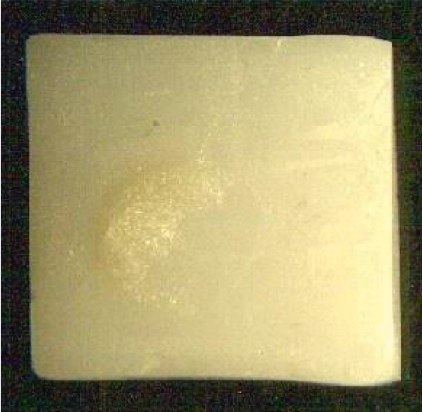
Figure 7: Mixed failure mode observed in zirconia-feldspathic ceramic assembly.